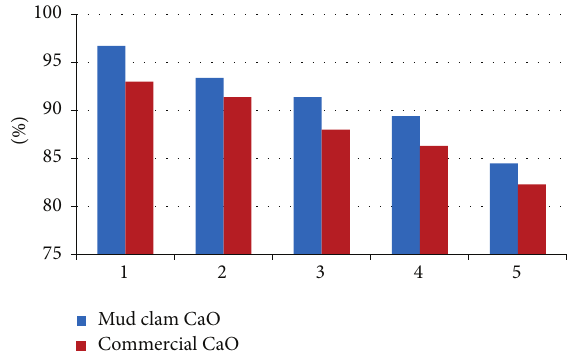
Figure 9: Effect of reusability of catalyst on biodiesel